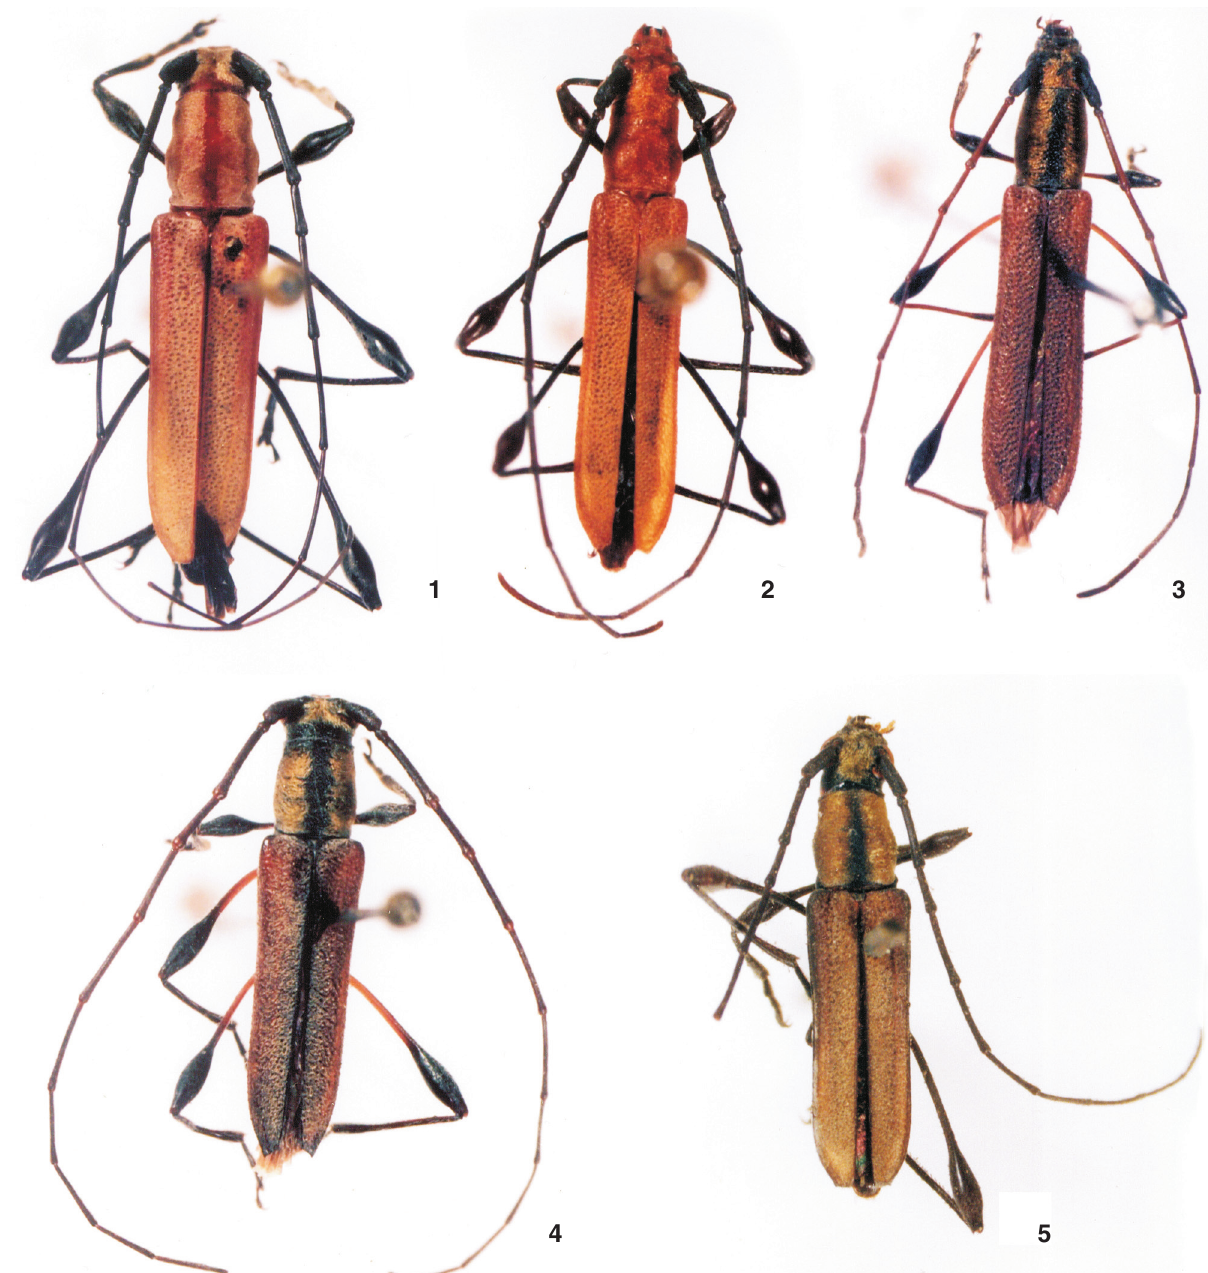
Figuras 1-5. Habitus: (1) Rhopalophora pulverulenta , macho, 13,7 mm; (2) R . neivai , macho, 8,5 mm; (3) R . casignata , holótipo macho, 7,3 mm; (4) R . dyseidia , holótipo macho, 8,6 mm; (5) R . venezuelensis , sintipo fêmea, 10,2